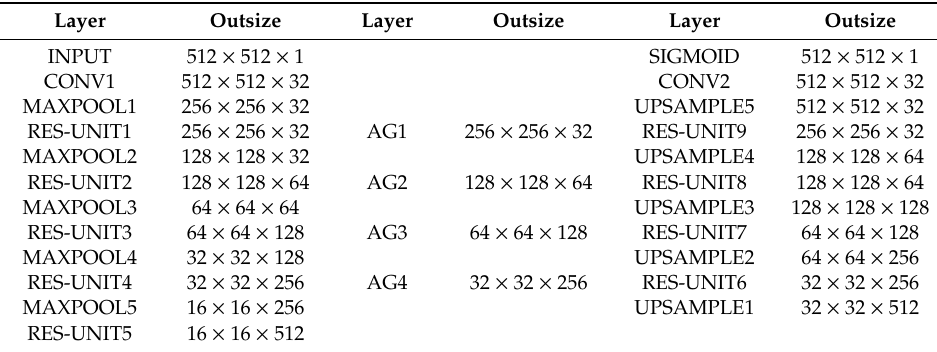
Table 2. Optimal results for two di ff erent load cases.